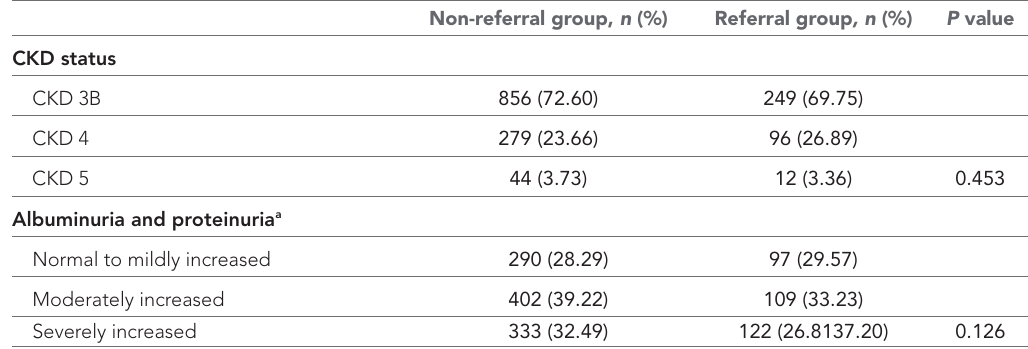
Table 2 Comparison of indicators of CKD severity (CKD status and albuminuria and proteinuria) of non- referral and referral